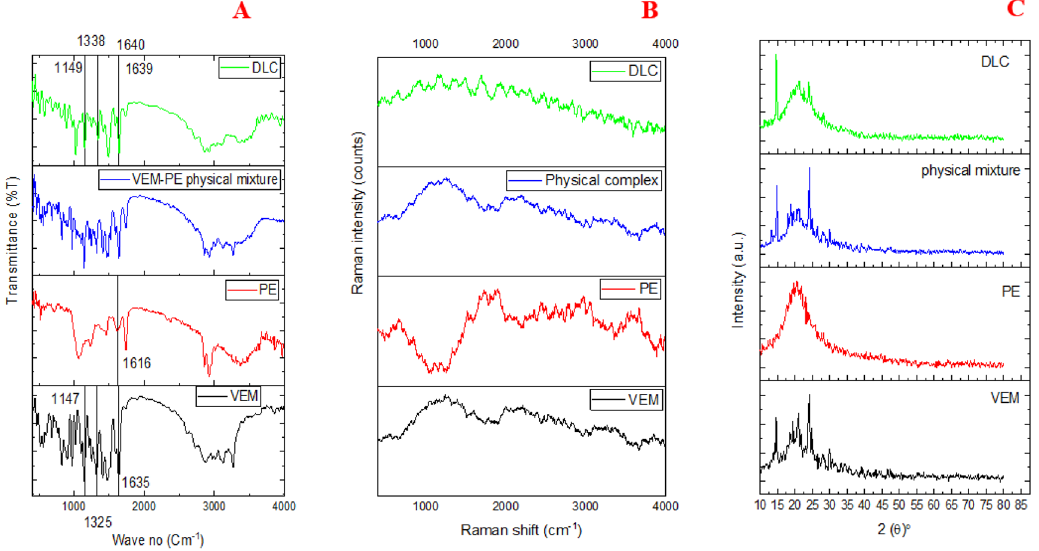
Figure 5. Characterization of VEM-PE complex (DLC)(A) FT-IR spectrum, (B) Raman spectroscopy, and (C) PXRD of VEM, PE, physical mixture of VEM and PE, and